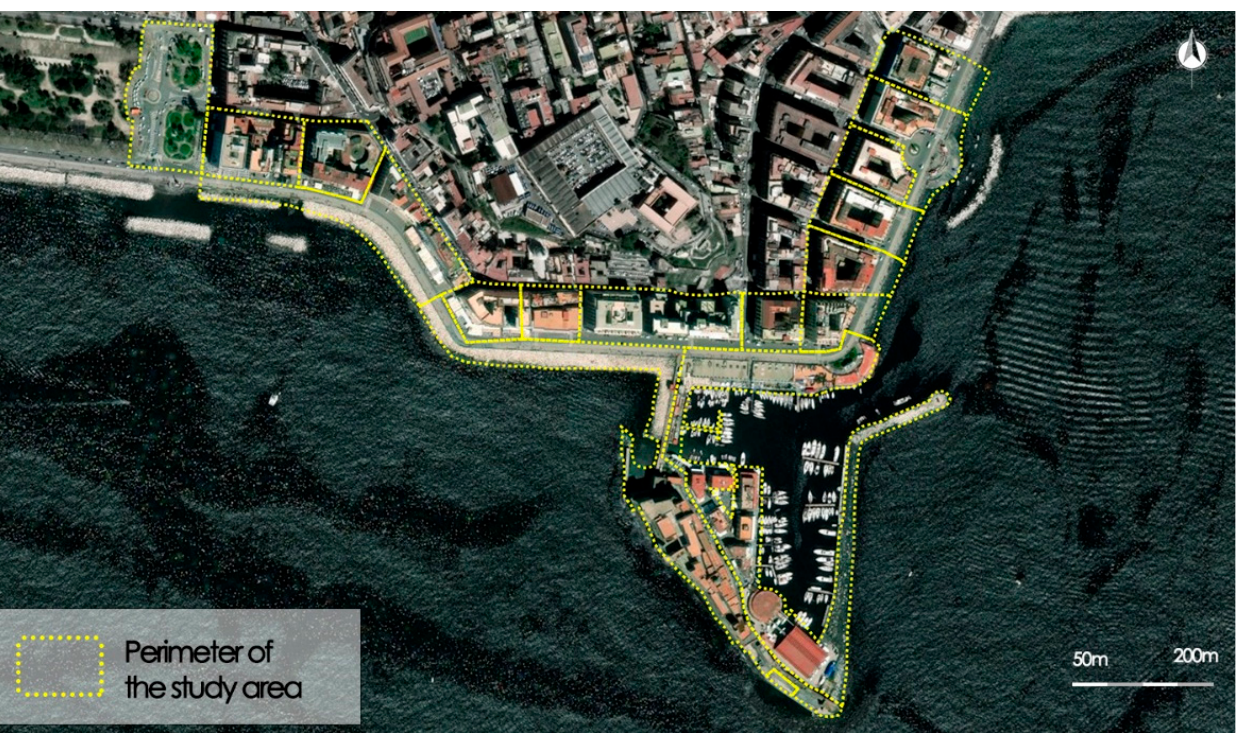
Figure 3. Case study area: Naples waterfront